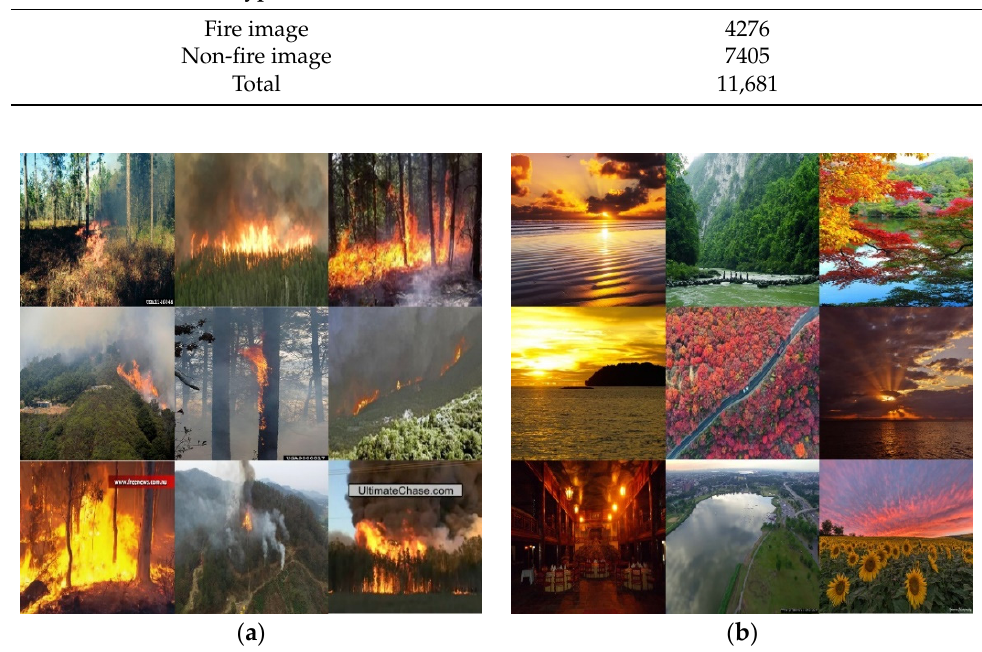
Figure 1. The samples of the dataset. ( a ) Forest fire images containing ground fires, trunk fires, canopy fires, etc.; and ( b ) non-fire images containing sunset, red leaves, red lantern, etc.